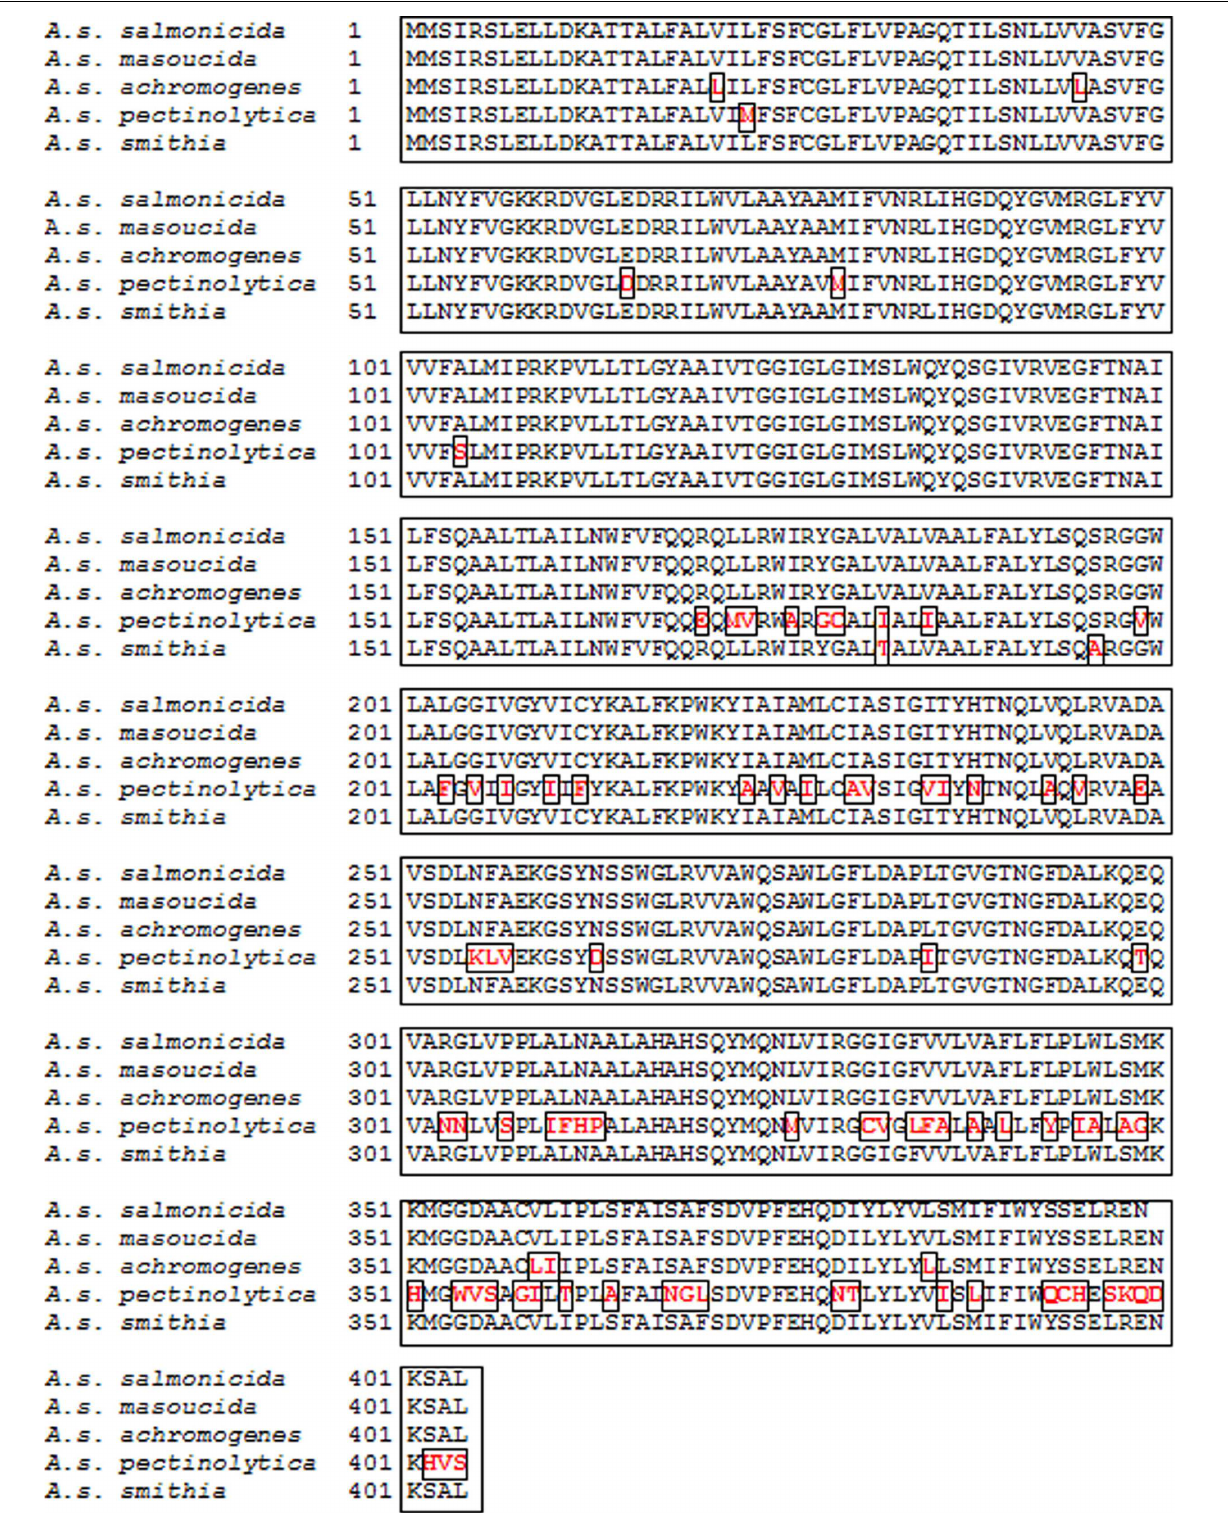
Frontiers in Microbiology |